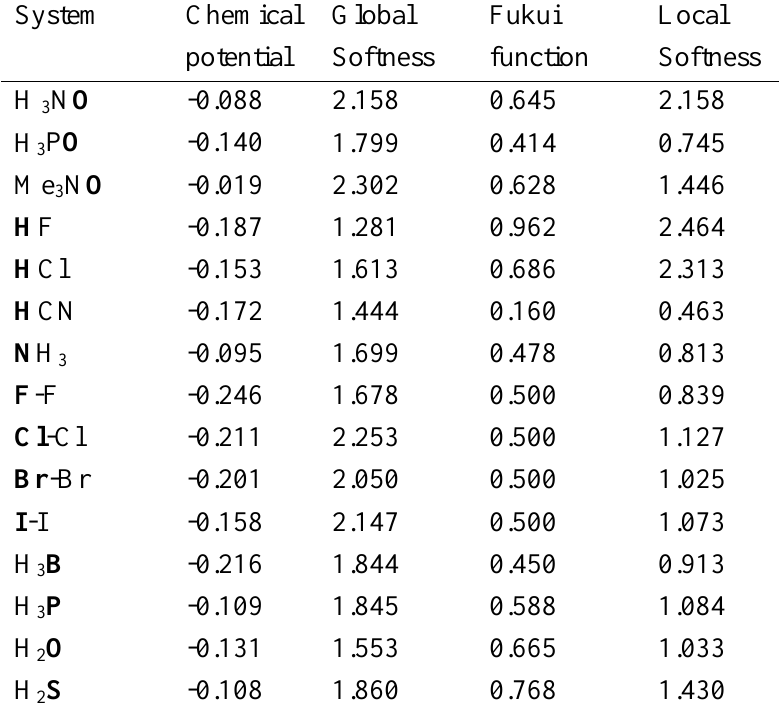
Table 1 : Global and local quantities of oxides, hydrogen halides, halogens and Lewis acids and bases. (Values in atomic units); Bolded atoms are the reactive atoms. Here the nucleophilic (Sk - ) atoms are O, N, P and S and the electrophilic (Sk + ) atoms are H, F, Cl, Br, I and B.